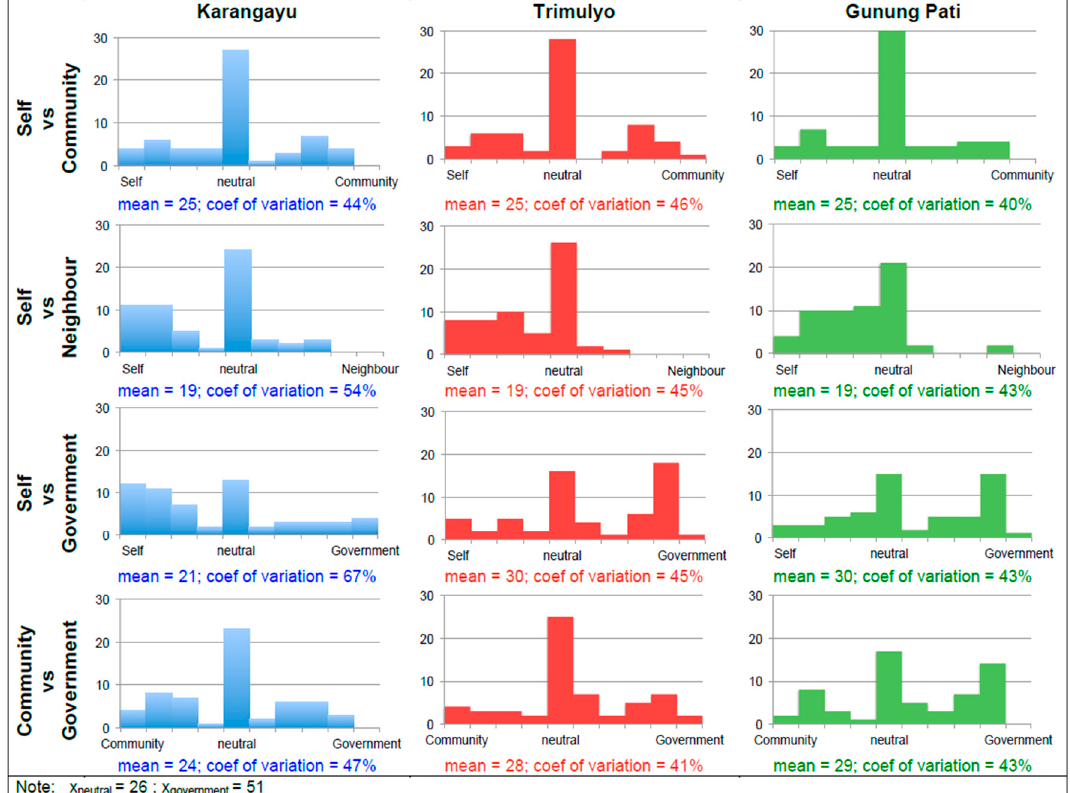
Figure 7. Matrix of histograms, means and standard deviations for flood prevention responsibility allocation for four pairs of stakeholders (y-axis: number of questionnaire participant responses).